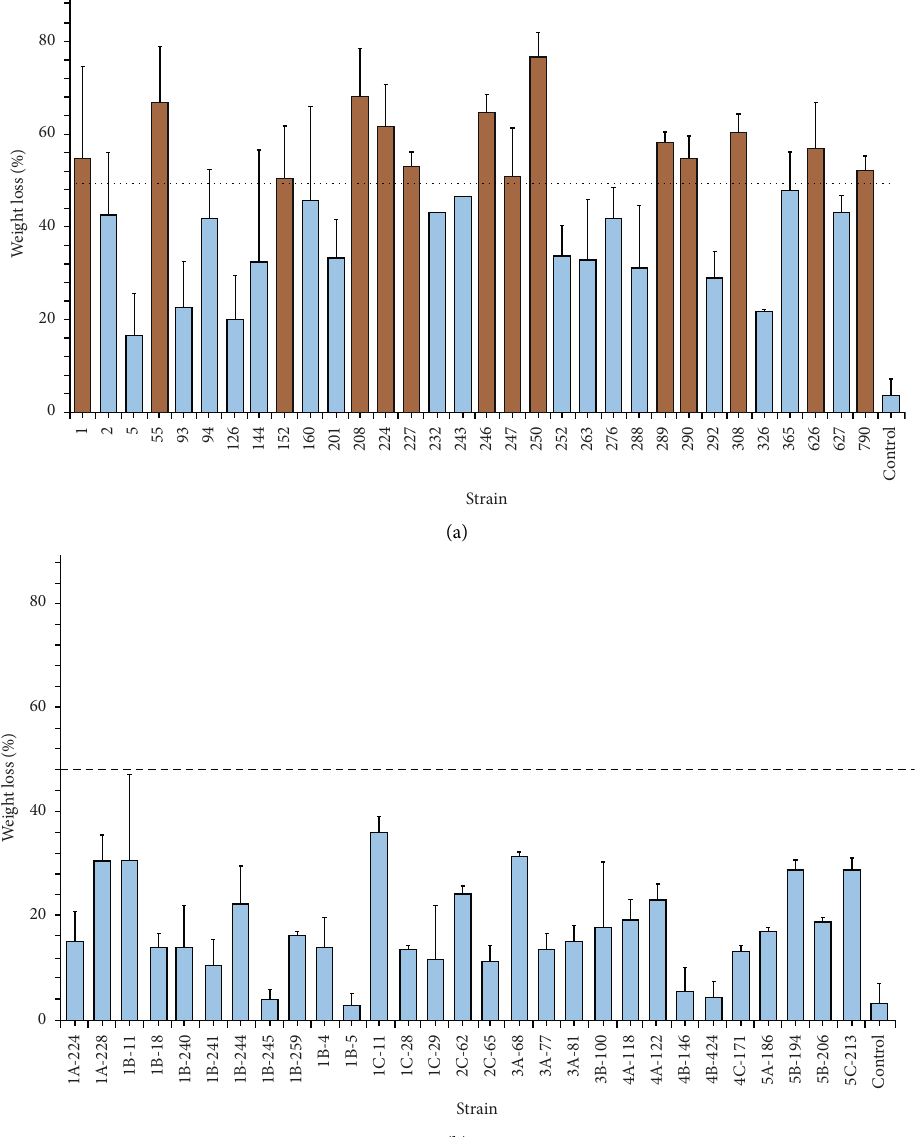
Figure 1: PVC weight loss percentage by each strain on modifed ISP-2 broth (a) Arauca isolates and (b) Guaviare isolates. “Control” is the negative control (MSM +PVC with no bacterial exposure). Te dotted line represents 50% of the weight loss established limit. Orange bars represent the strains that were further analyzed. All values are presented as mean ± error of data based on experiments performed in triplicate. Bars indicate the standard deviation of